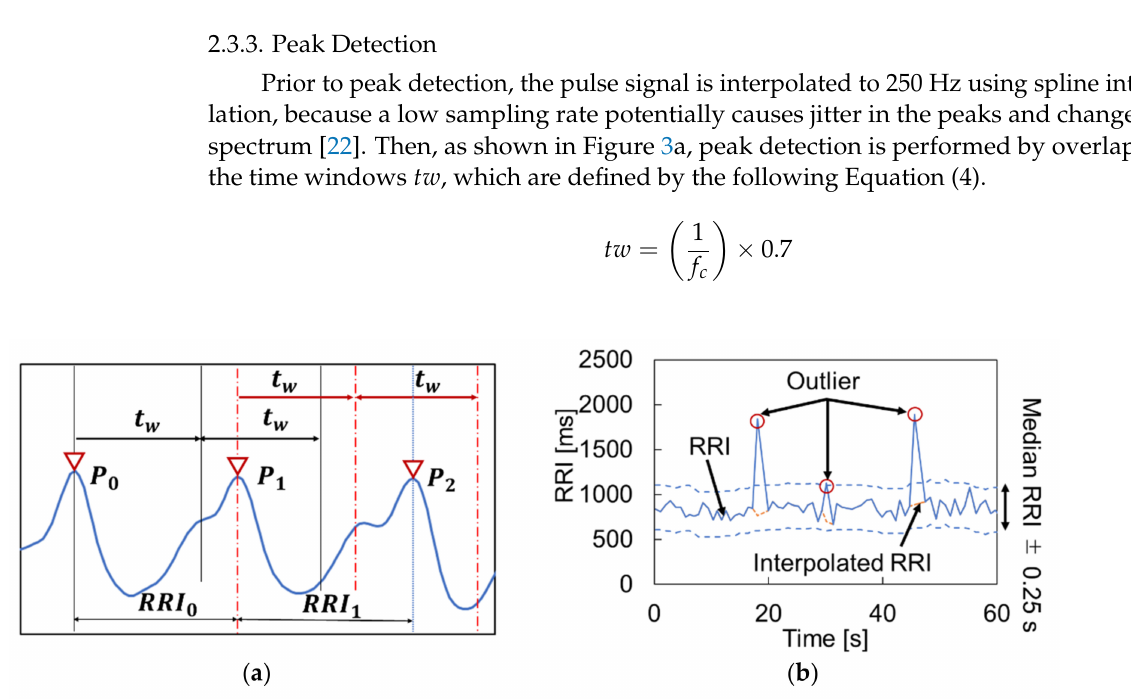
Figure 3. Processing procedure: ( a ) peak detection procedure and ( b ) peak